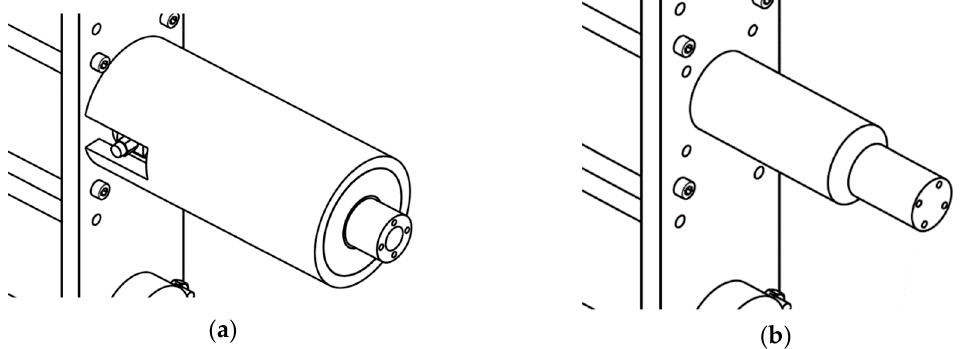
Figure 12. Compression system: ( a ) with a load cell; ( b ) without load cell (no scale).